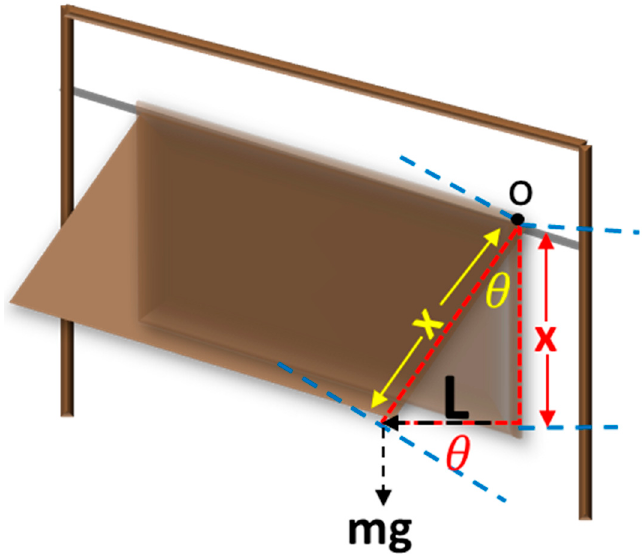
Figure 2. Air-Odo theory of operation, showing the effect of wind on the resisting plate.